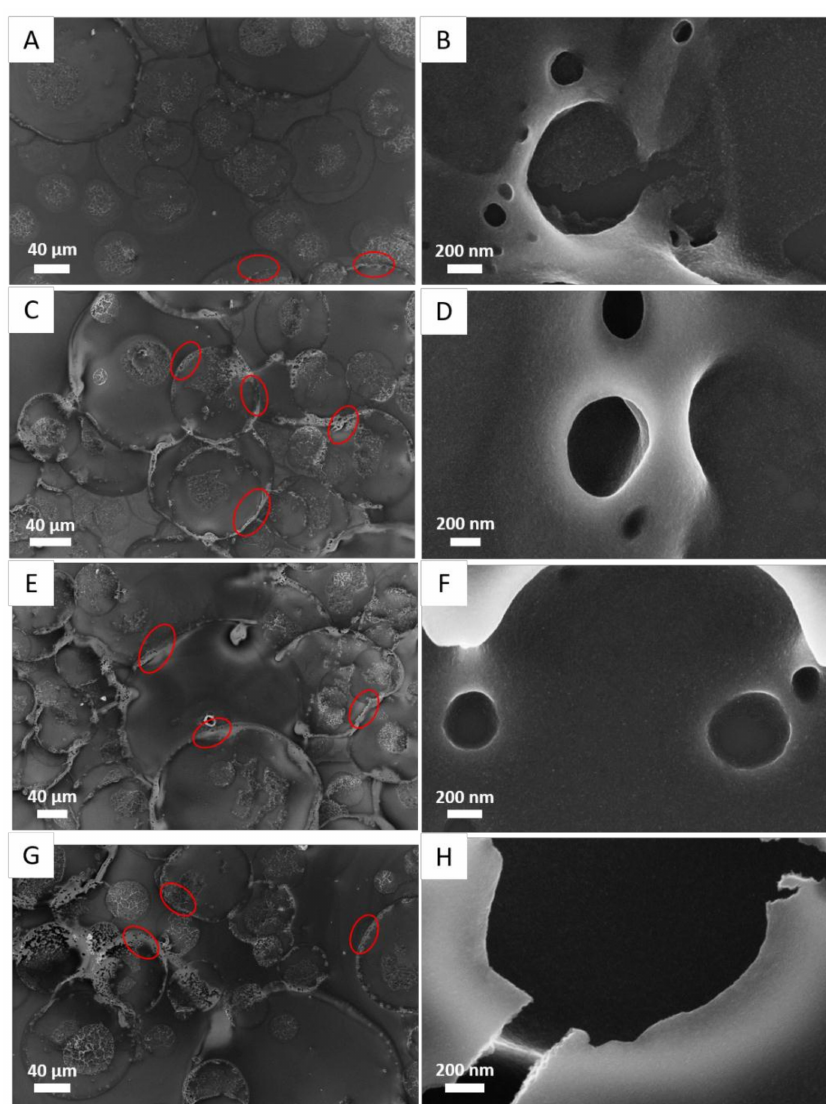
Figure 4. The SEM micrographs of TiO 2 NRs deposited by spray coating on silicon substrates from a chloroform solution of 0.02 M. The micrographs are low magnification (right column) and high magnification (left column) images respectively of coatings obtained with an application time of 1 min (A-ch A and B ), 1 min 30 s (B-ch C and D ) 2 min (C-ch E and F ) 2 min 30 s (D-ch G and H ). The measurements were performed with an accelerating voltage of 5 kV, a working distance of 1.4 mm and an aperture size of 20 µ m. The EDS spectrum of sample A-ch was reported in the